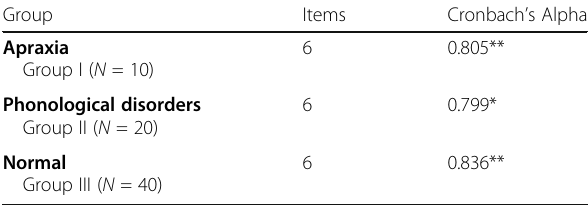
Table 3 Internal consistency reliability of CAS test battery